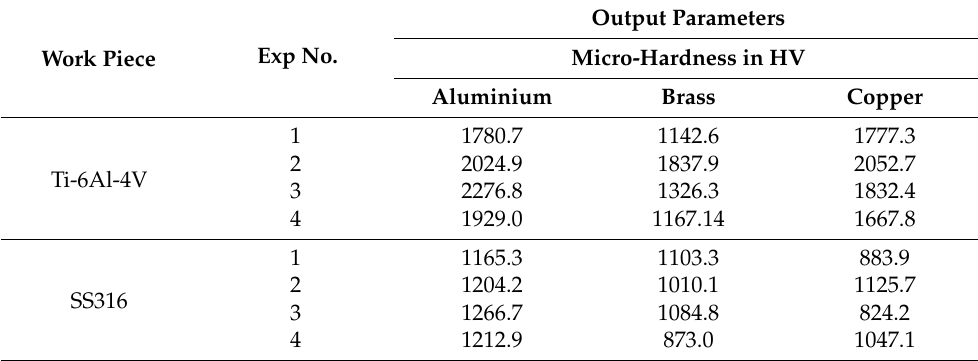
Table 10. The values of micro-hardness (HV) for different work pieces with different tool–work piece combinations for different experiments.